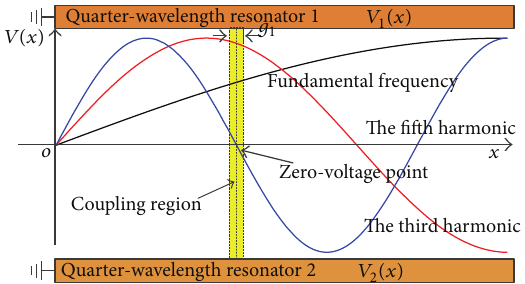
Figure 3: Voltage wave functions along the quarter-wavelength